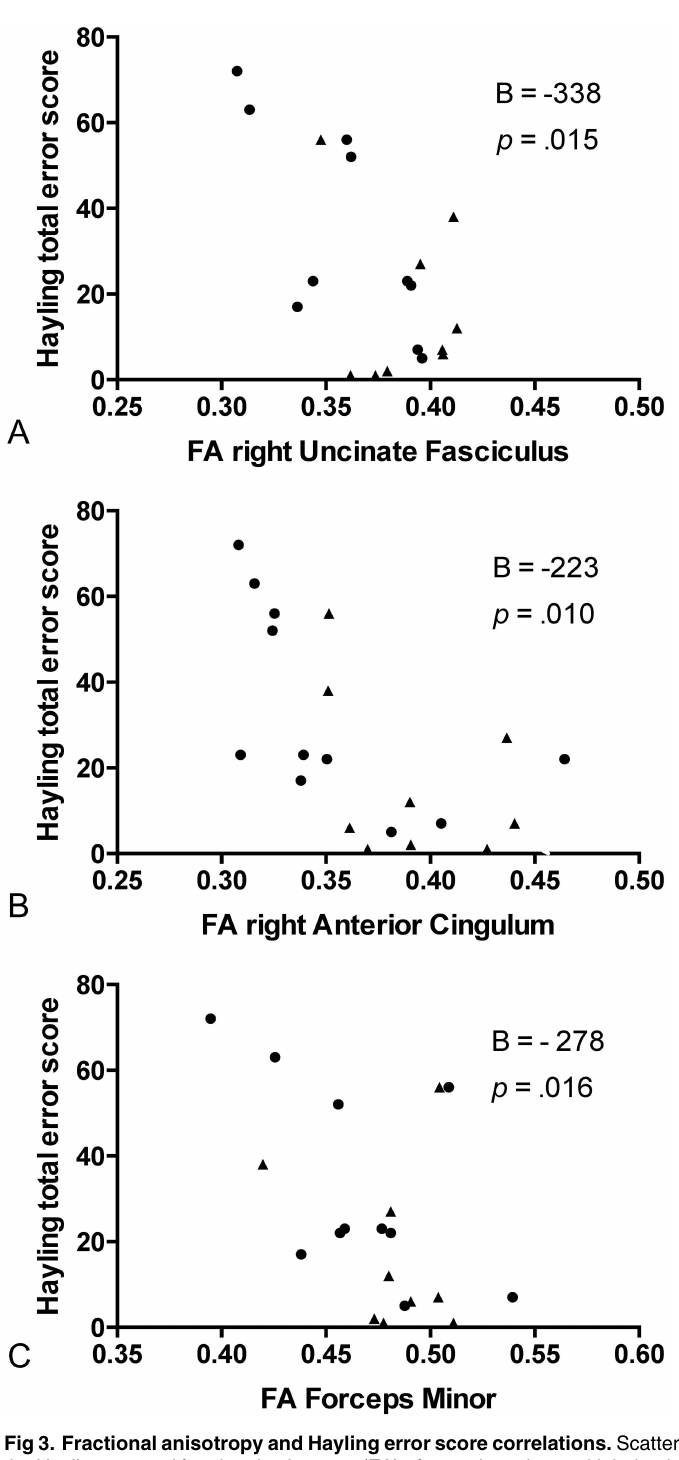
Fig 3. Fractional anisotropy and Hayling error score correlations. Scatter plots of total error score on the Hayling test and fractional anisotropy (FA) of tracts in patients with behavioural variant frontotemporal dementia (dots) and progressive supranuclear palsy (triangles), for A: the right uncinate fasciculus, B: the right anterior cingulum,and C: the forceps minor. B (adjusted) and p are derivedfrom the linear regression model, with age as